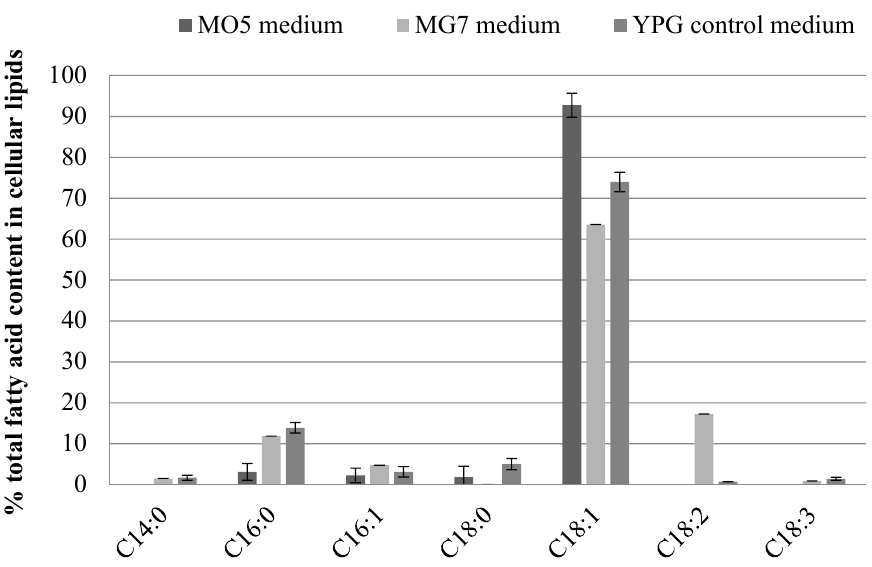
Figure 2. The composition of fatty acids in lipids synthesized in cells during Y. lipolytica batch cultures in MG7 (containing glucose), MO5 (containing olive oil), and YPG control media